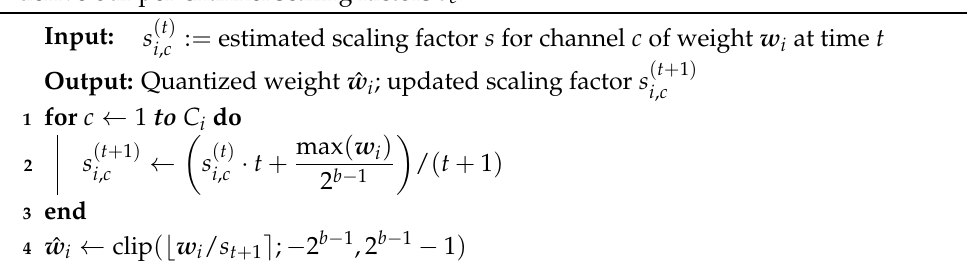
Algorithm 3: Our adaptive symmetric quantization algorithm for the set of weights w i for layer i using per-channel scaling factors. We use moving average statistics to estimate the maximum weight magnitude for each channel c to derive our per-channel scaling factors s c